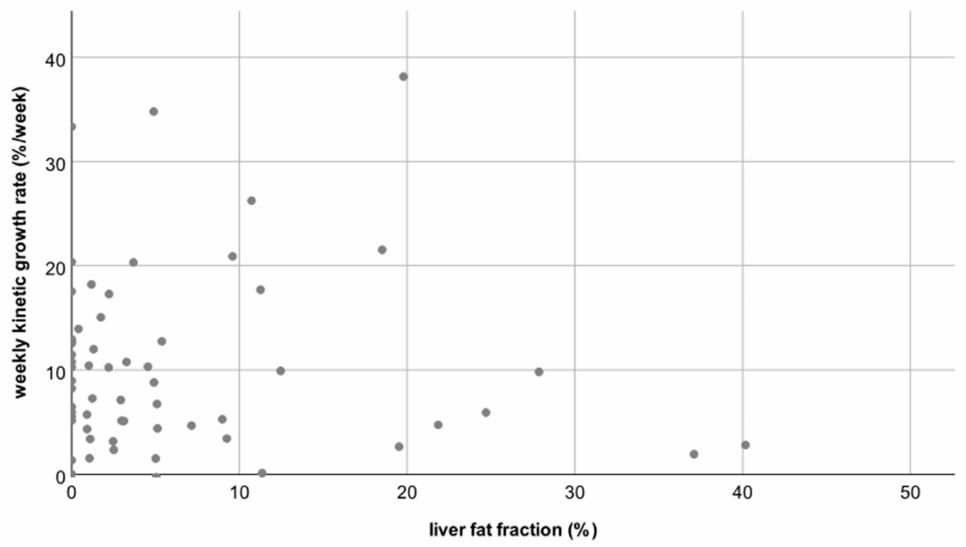
Figure 4. Scatterplot B: No correlation between the liver fat fraction (hFF) and the weekly kinetic growth rate; correlation coefficient R = −